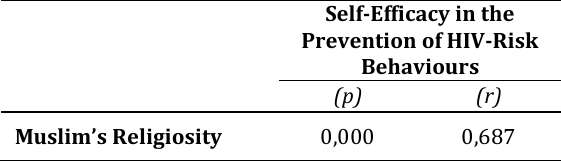
Table 3. The Correlation Test Results between Muslim